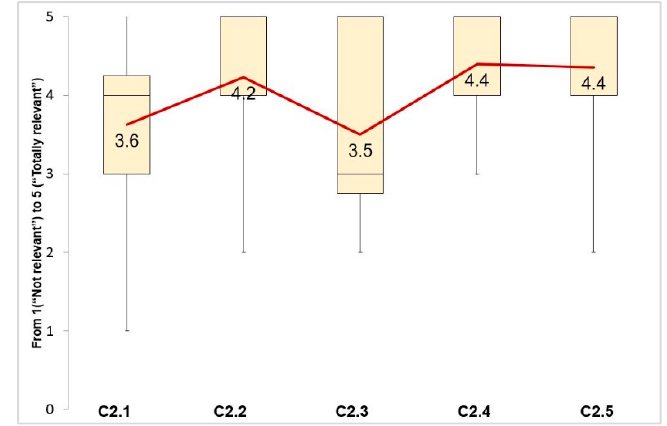
Figure 3. Relevance level (average and range) of economic and financial factors.